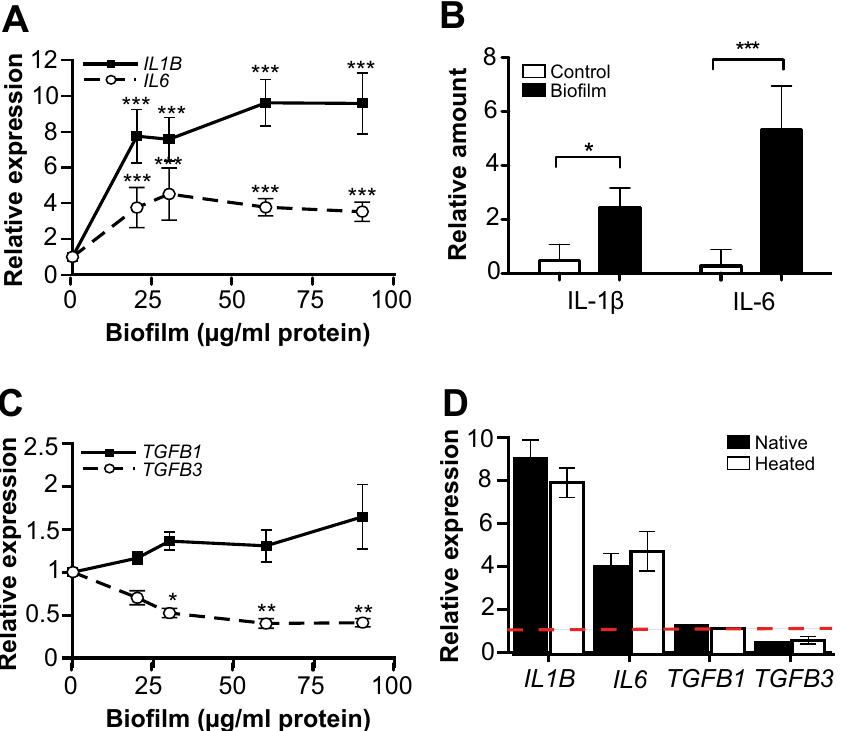
Figure 3. Inflammatory cytokine expression in biofilm-treated GECs. ( A and C) GECs were exposed to various concentrations of oral biofilm extract (#4 biofilm; 0–90 µ g protein/ml) for 32 h. RT-qPCR was then performed to assess the relative gene expression of (A) IL1B (n = 5) and IL6 (n = 4) and ( C ) TGFB1 (n = 6) and TGFB3 (n = 4). Mean ± SEM is presented. ( B ) The amount of IL-1 β and IL-6 secreted in the cell culture medium was determined by ELISA. ( D ) GECs were treated with either native or heated biofilm #4 extract (60 µ g protein/ml) for 32 h and analyzed for IL1B , IL6 , TGFB1 and TGFB3 expression by RT-qPCR (n = 3–5). Dashed line indicates control expression level. * p < 0.05; ** p < 0.01; *** p <